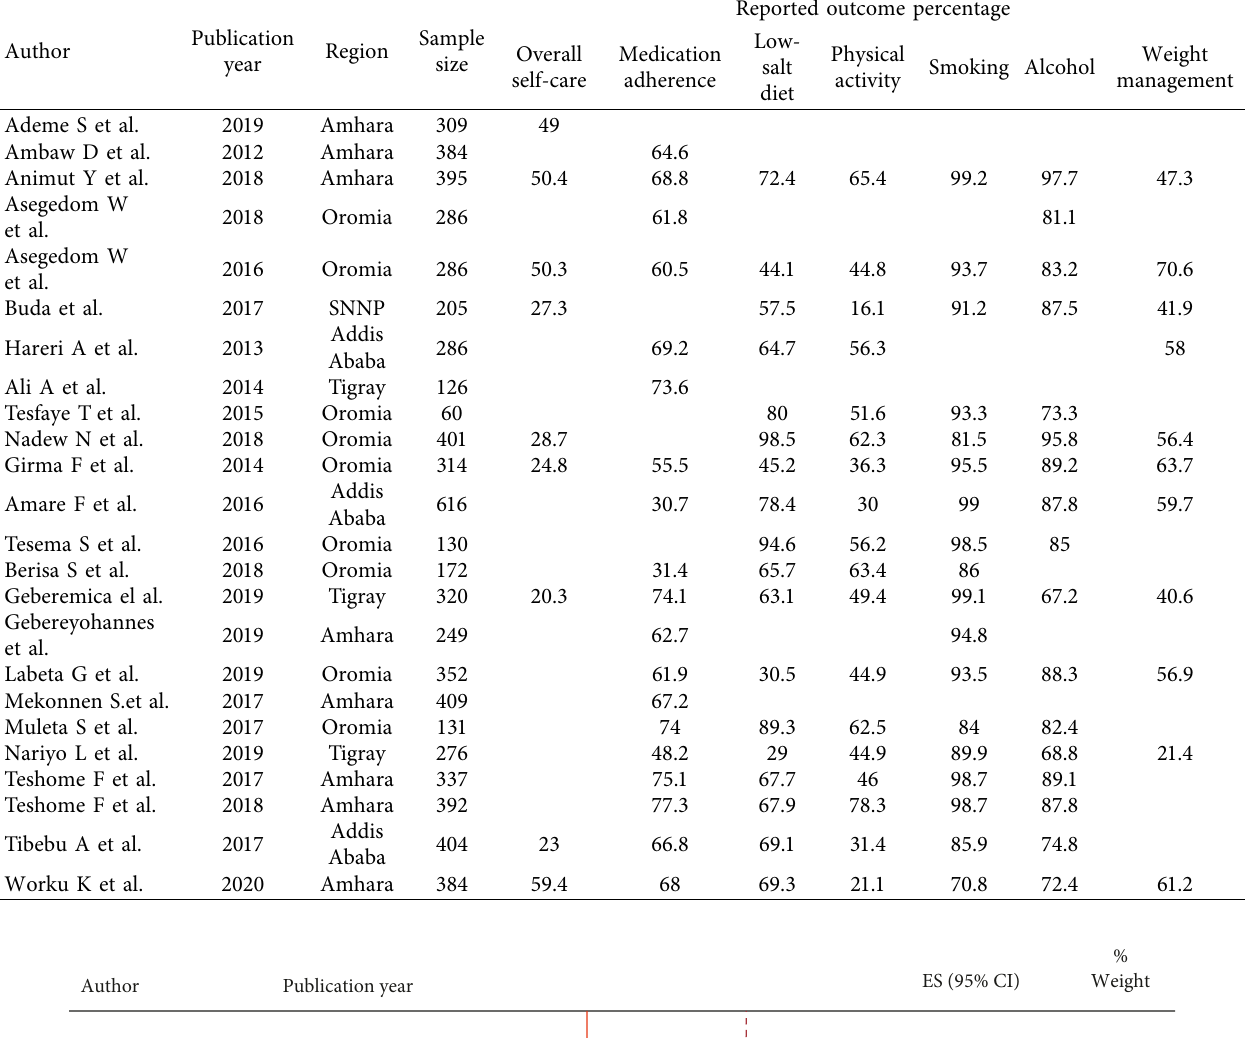
Table 1: Characteristics of included studies in the final systematic review and meta-analysis, 2020.